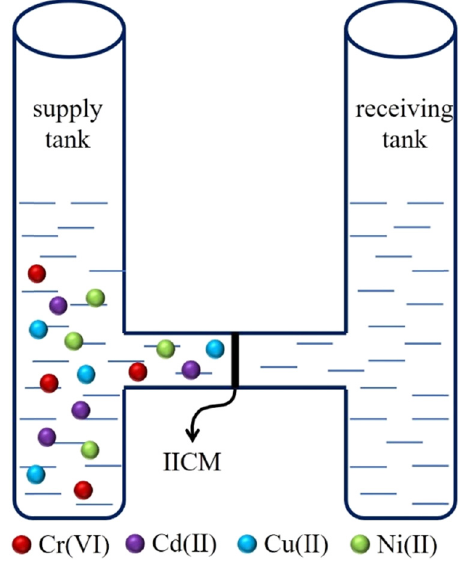
Figure 1: Permeability device.